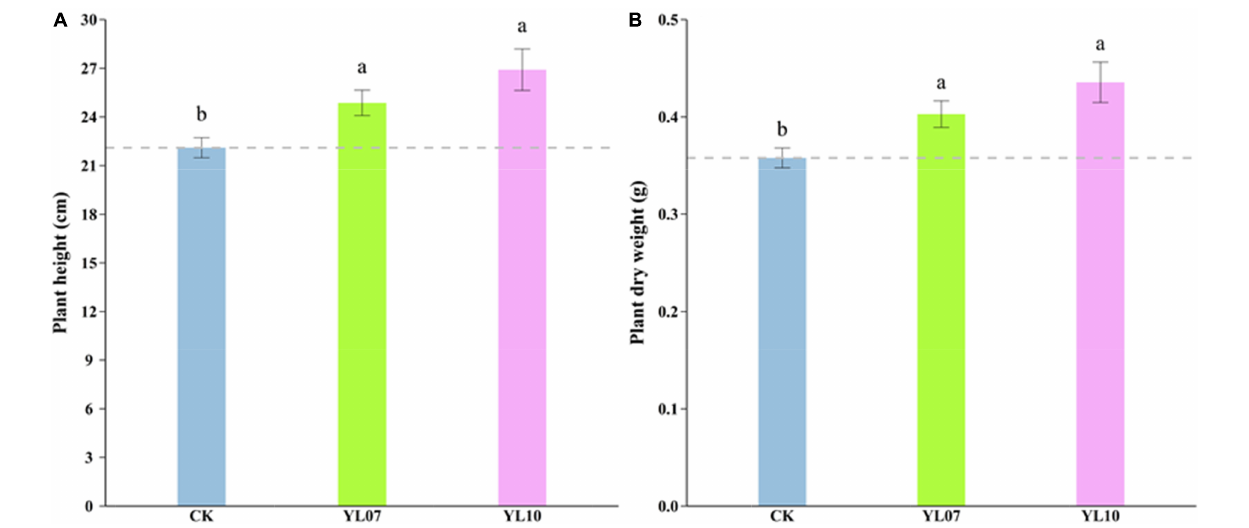
FIGURE 1 | Effect of strains YL07 and YL10 on the plant height (A) and dry weight (B) of maize under NaCl stress. Different letters indicate significant differences at the P < 0.05 level among the different treatments, as determined by LSD post hoc comparison tests. TABLE 1 | Effects of YL07 and YL10 strain inoculation on nutrient elements and essential ion absorption by maize seedlings grown in pots under NaCl stress.